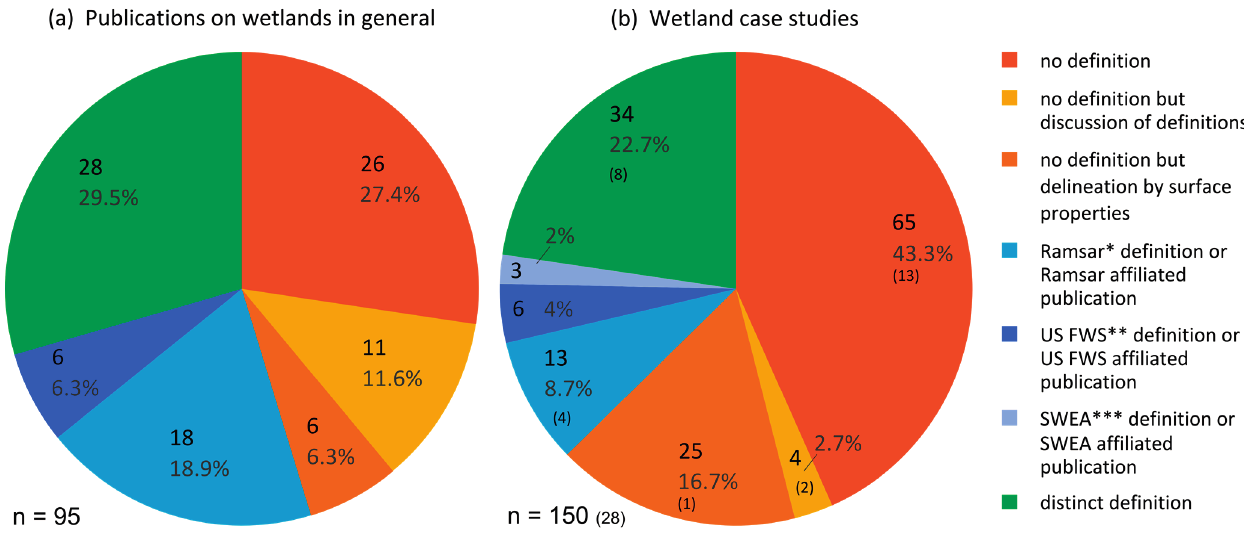
Figure 1. Quantitative analysis of wetland definitions reflected in publications on wetlands in general ( a ) and in case studies on wetlands ( b ). Figures shown in brackets in the right portion of the graphic refer to studies that are not specific to the field of remote sensing, but are important either for the GlobE Wetlands project or for general wetlands